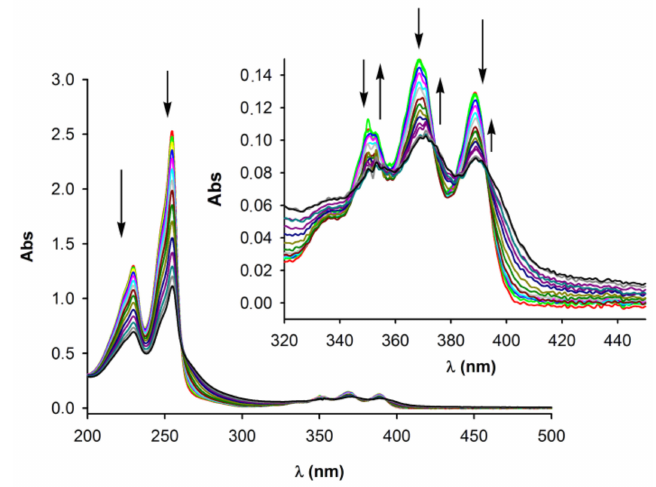
Figure 4. Changes in the absorption spectra of the receptor 5 2+ · 2PF 6 − ( c = 1 × 10 − 5 M in CH 3 CN) upon addition of increasing amounts of H 2 PO 4 − anions. Arrows indicate the absorption bands that increase or decrease during the